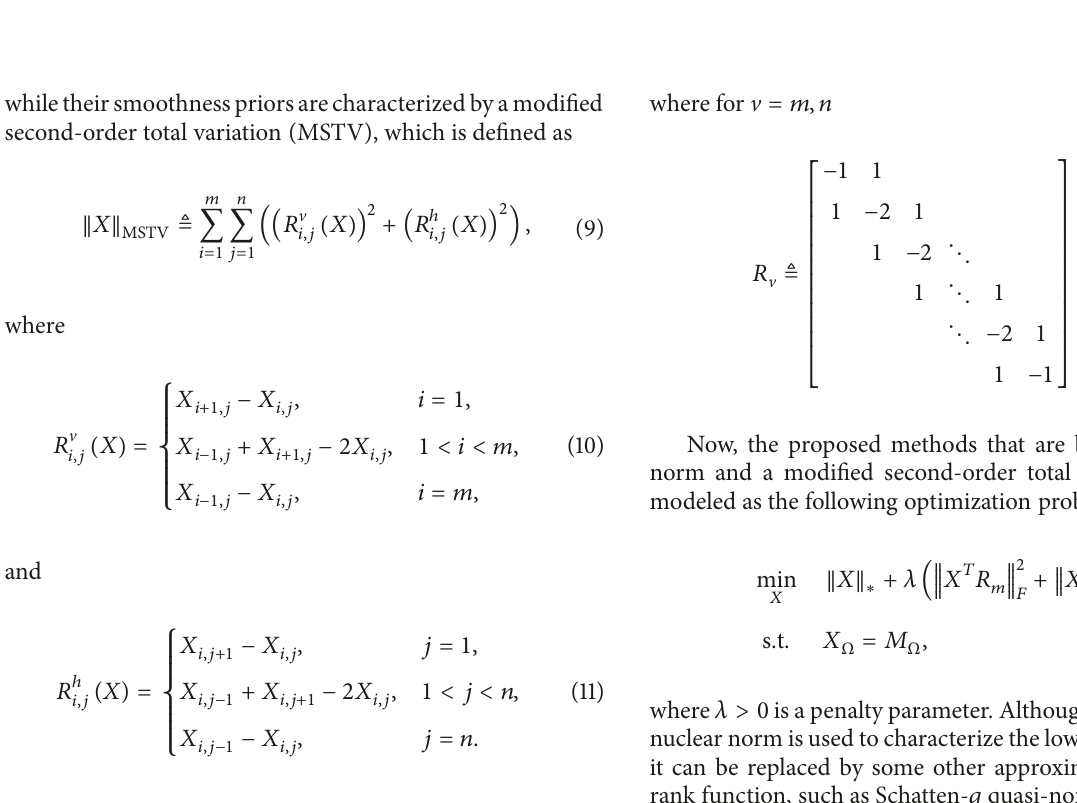
Figure 2: The black points denote the local but nonedged entries, the red points denote the corresponding neighboring entries concerned in LTVAandourMSTV,andthegreypointsdenotetheremainingentriesofmatrices.Obviously,ourMSTVtakesmoreinformativeneighboring entries into consideration and hence yields a better